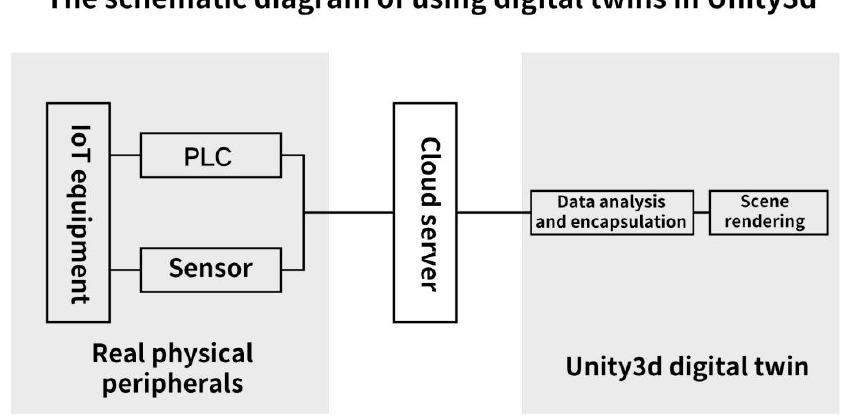
Figure 1. Design of the digital twin software.